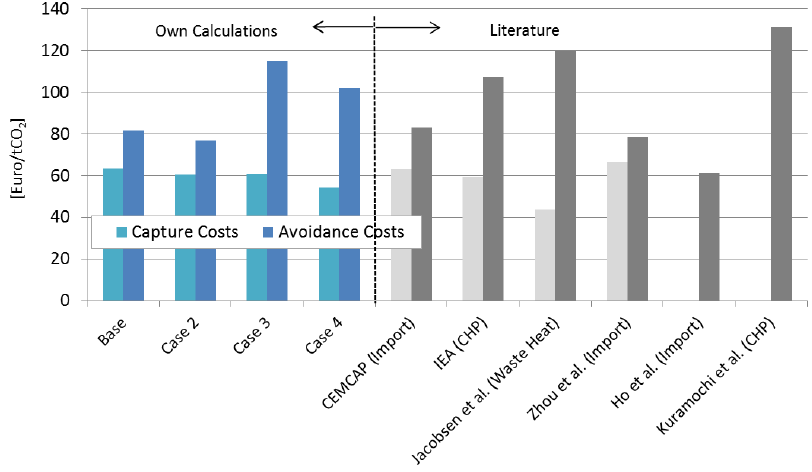
Figure 6. CO 2 capture and avoidance costs for the present study and the literature (steam sources indicated in brackets); values in USD were converted to EUR with USD/EUR = 1.11.